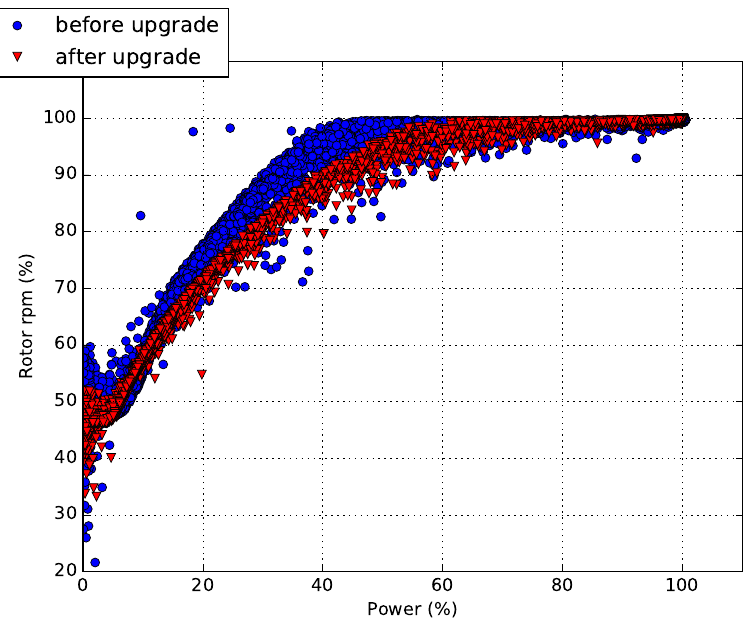
Figure 2. The rotor rpm–power curves before and after the